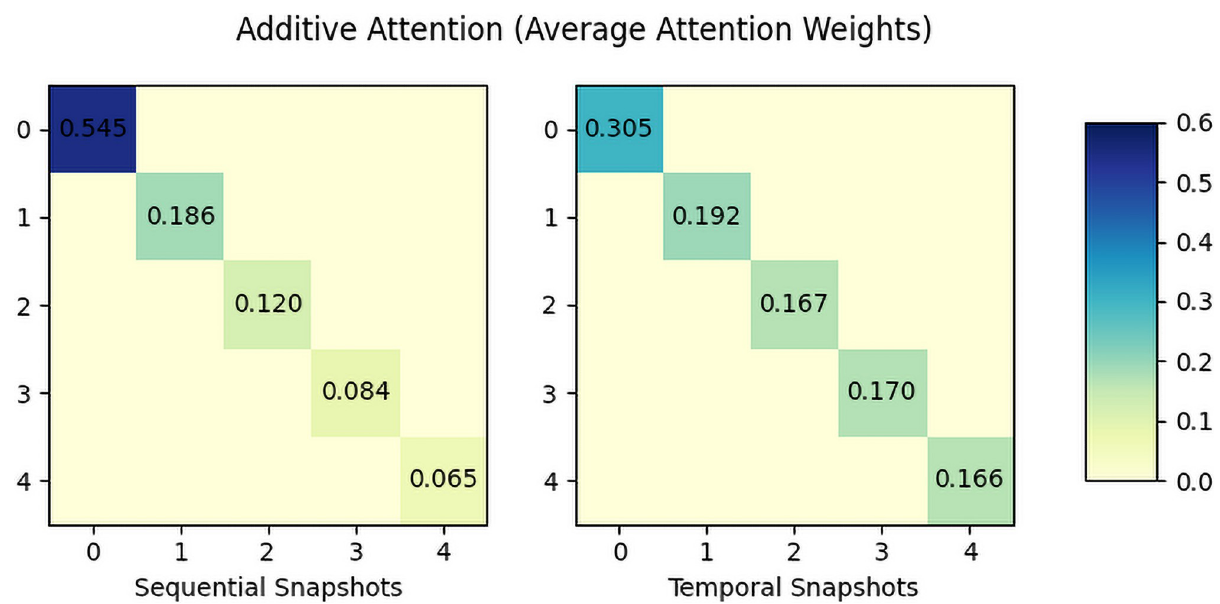
Fig 6. Average attention weights of additive attention on Twitter16 .